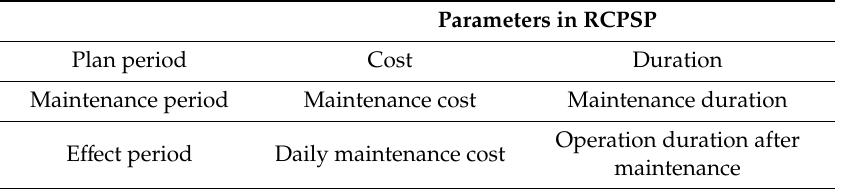
Table 2. Parameters of two periods corresponding to RCPSP.